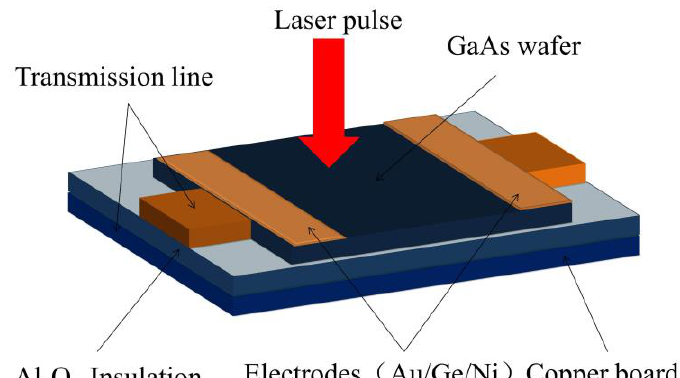
Figure 1. Schematic diagram of a lateral PCSS.